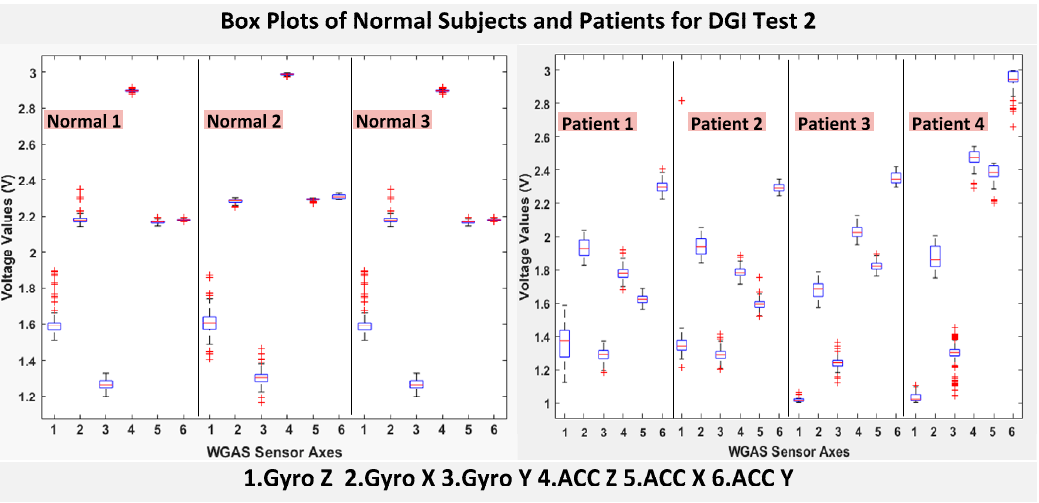
Figure 4. Box plots of DGI Test 2: Data for normal subjects (left) vs. patients (right).